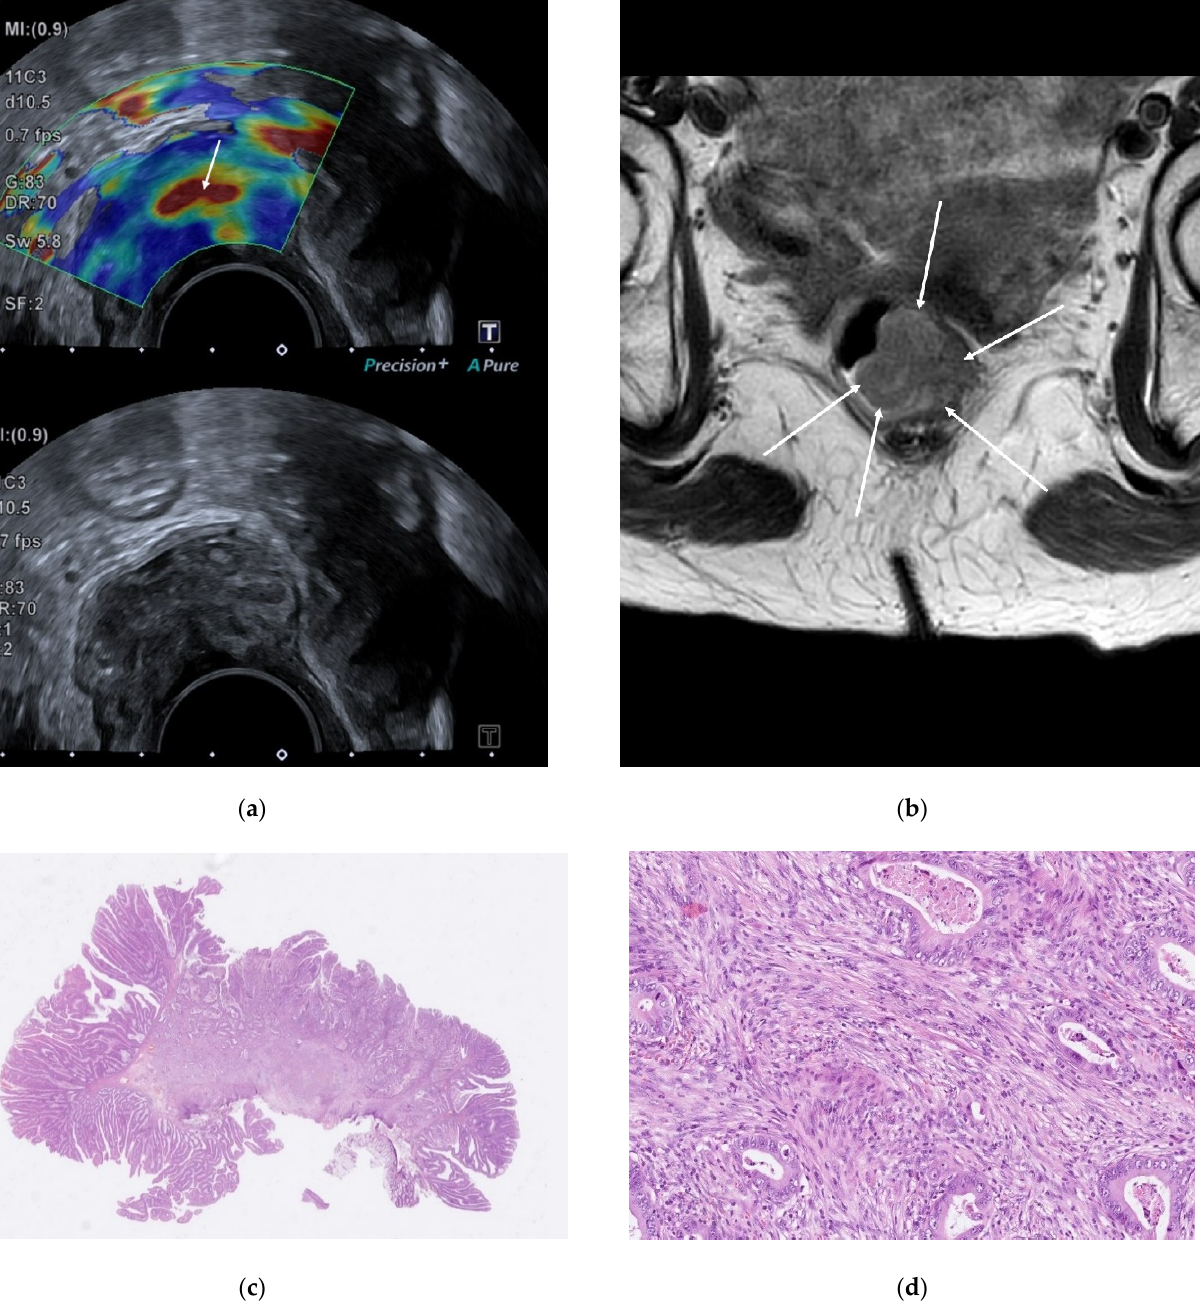
Figure 2. A 93-year-old female patient. ( a ) Endorectal ultrasound with shear-wave elastography color map on the upper image and the corresponding B-mode on the lower image. Within the lesion is a red (hard) area. ( b ) Magnetic resonance T2-weighted image of the lesion. The white arrows indicate the lesion boundaries. ( c ) Histopathology revealing an adenomatous polyp with a central focus of adenocarcinoma. ( d ) 200× magnification shows an SF of 70%.